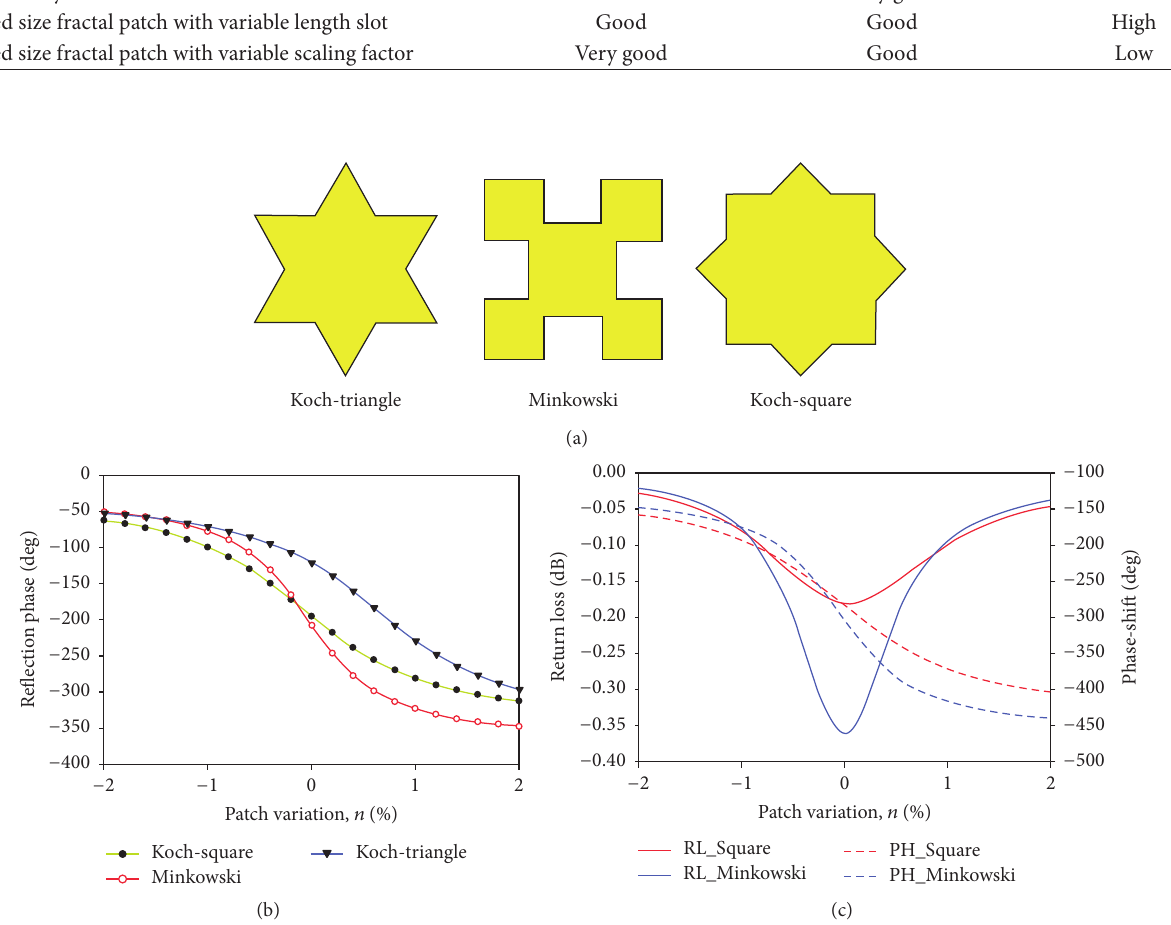
Figure 1: Simulated fractal reflectarray unit cells ( 𝑓 0 = 11 GHz, 𝜀 𝑟 = 3.54 , and thickness = 1.524 mm): (a) variable size fractal patches; (b) comparison between reflection phase curves versus patch variation percentage ( 𝑛 %) computed for Koch-square, Koch-triangle, and Minkowski patches; (c) comparison between reflection coefficient responses versus 𝑛 % computed for Minkowski and square